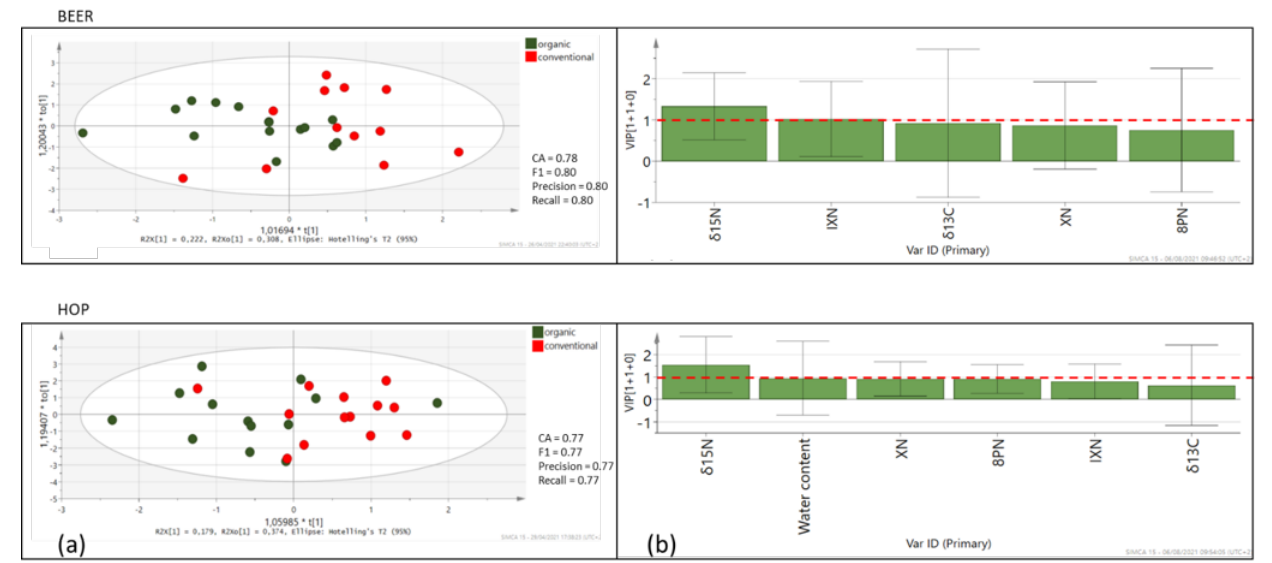
Figure 5. OPLS-DA score plots ( a ) with VIP values ( b ) in the pairwise comparison between different production practices for beer and hops. The red-dotted line at VIP = 1.0 indicates criteria for the identification of the most important model variable.